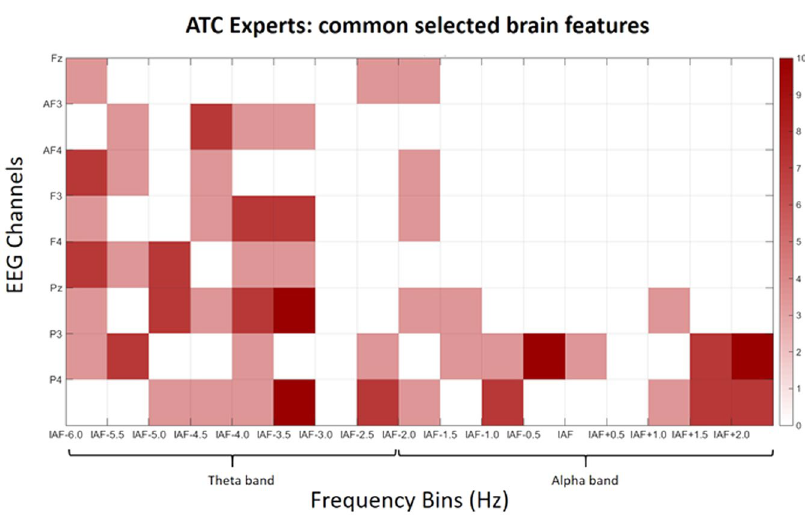
Figure 12. Percentages related to the brain features most commonly selected by the asSWLDA across the ATCO Experts for the SRK-based cognitive control behaviours discrimination. White color means that brain features have not been selected at all. On the contrary, the red colors means that the brain features were selected more